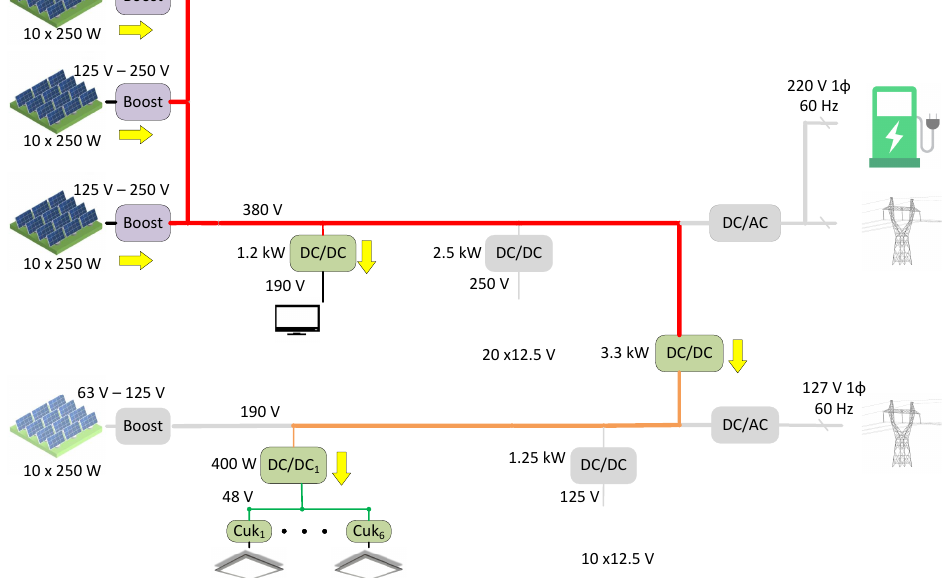
Figure 32. Second test trajectory for DCMG multibus multi-voltage performing with three boost converters.